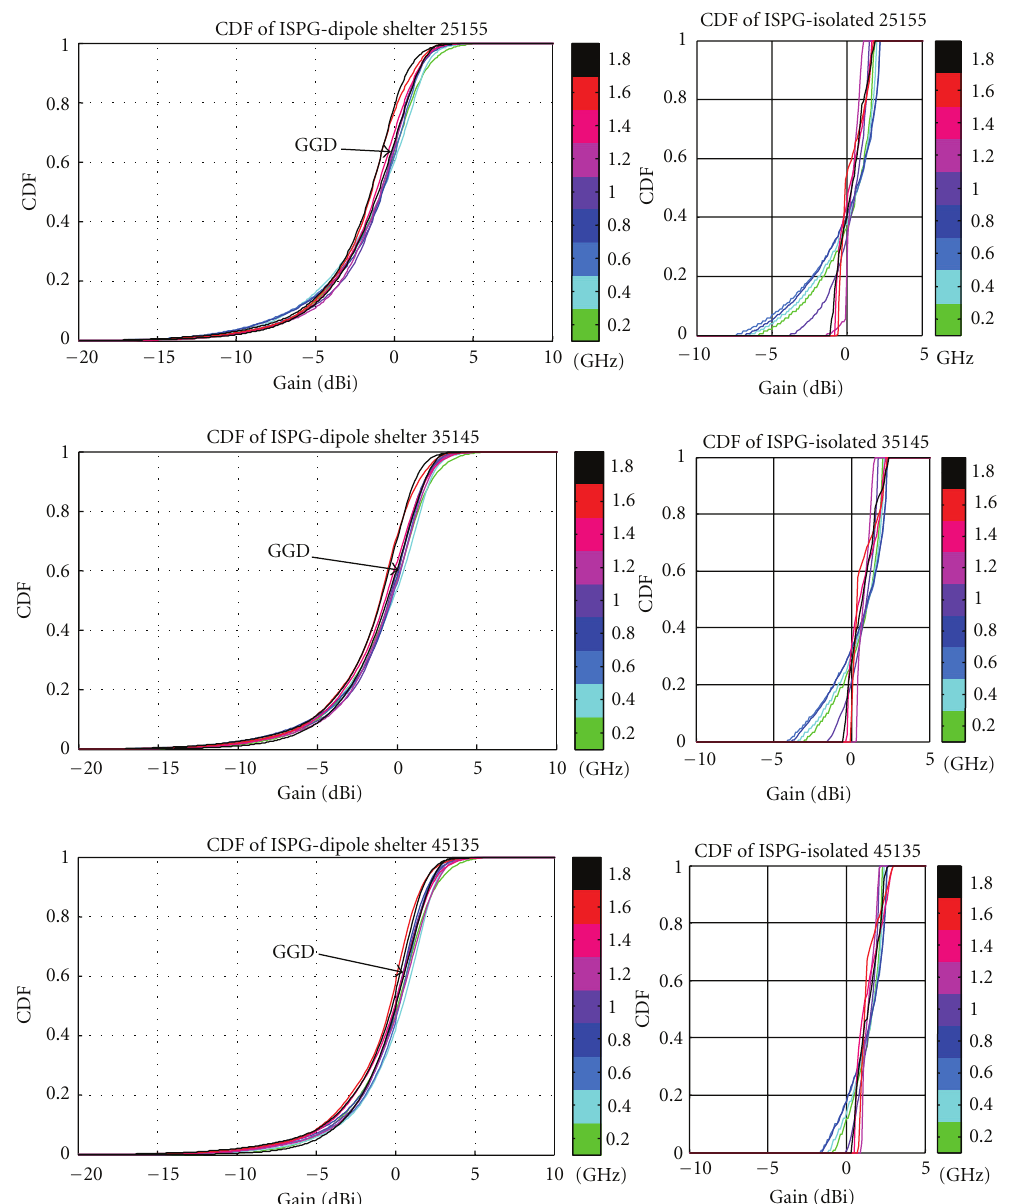
Figure 20: ISPG distribution for antenna-shelter and various sector widths in elevation: (25–155 ◦ ), (35–145 ◦ ), and (45–135 ◦ ) (from top to